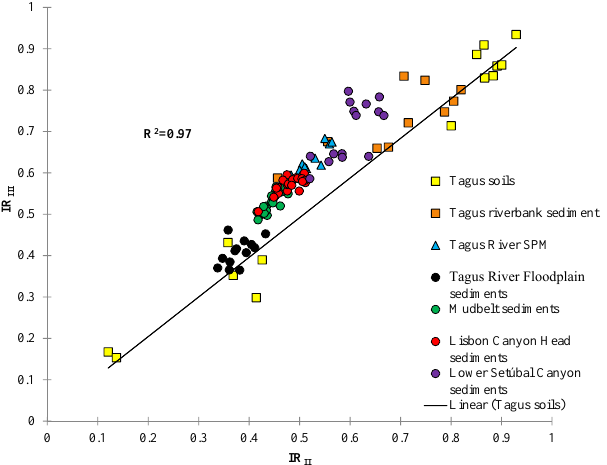
Figure 4. Isomer ratio for the non-cyclized pentamethylated brGDGT (IR II ) plotted against that of the non-cyclized hexamethy- lated brGDGT (IR III ) .